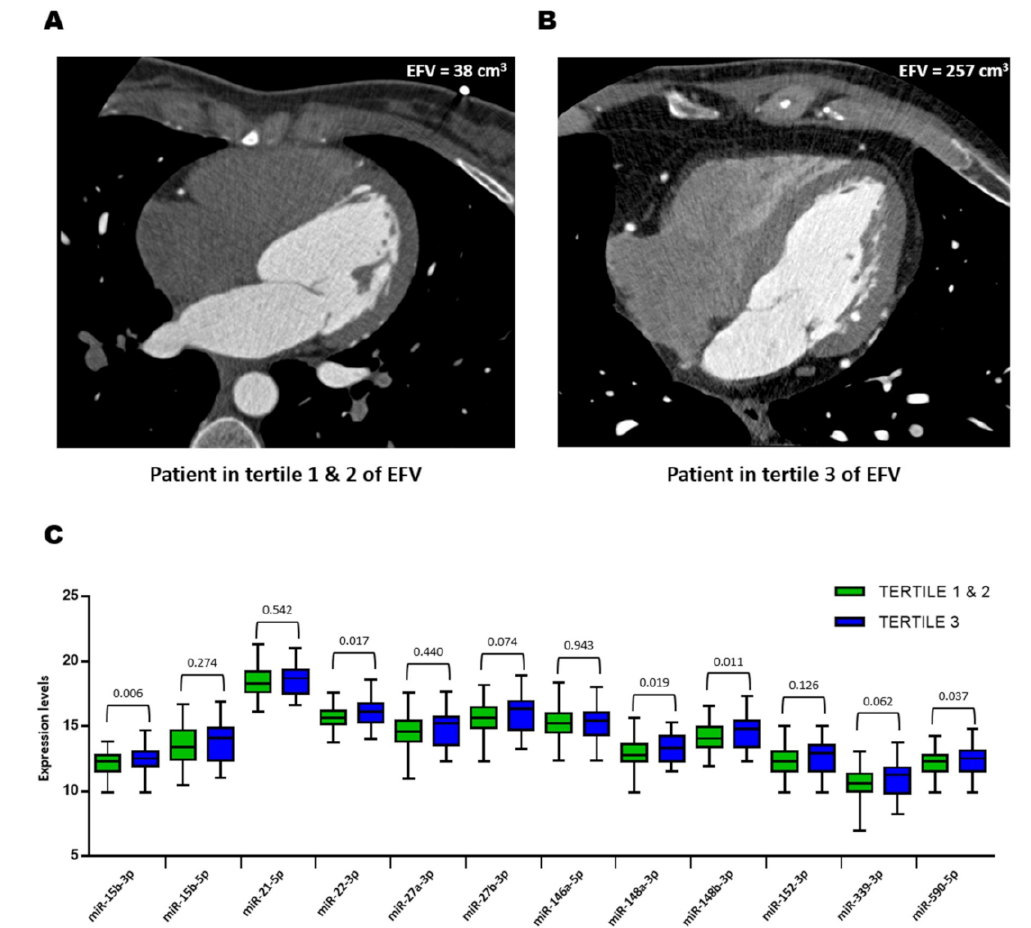
Figure 2. Plasma microRNA (miRNA) validation. ( A–B ) Examples of multidetector computed tomography scans and the corresponding epicardial fat volume of patients in the first-second and third tertiles of epicardial fat volume. ( C ) Plasma expression levels of miRNAs in study groups. MicroRNA levels were log 2 -transformed. MicroRNA expression levels are expressed as arbitrary units. Di ff erences between groups were analyzed using Student’s t -test for independent samples. p values describe the significance level of di ff erences for each comparison. EFV: epicardial fat